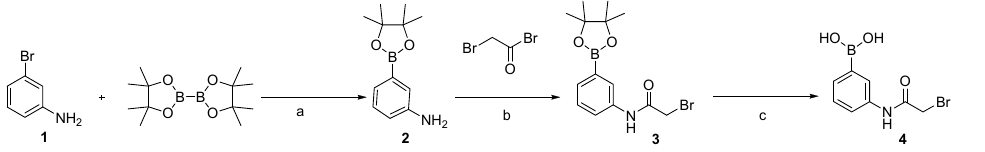
Scheme 1. Synthesis of boronic acid (BA)-linker: (a) Pd(dppf)Cl 2 , CH 3 COOK, dioxane, 80 °C, 12 h, 91%; (b) K 2 CO 3 , CH 2 Cl 2 , 0 °C to rt, 5 h, 80%; (c) NaIO 4 , 2N HCl, THF: H2O (4:1), rt, 5 h, 85%.